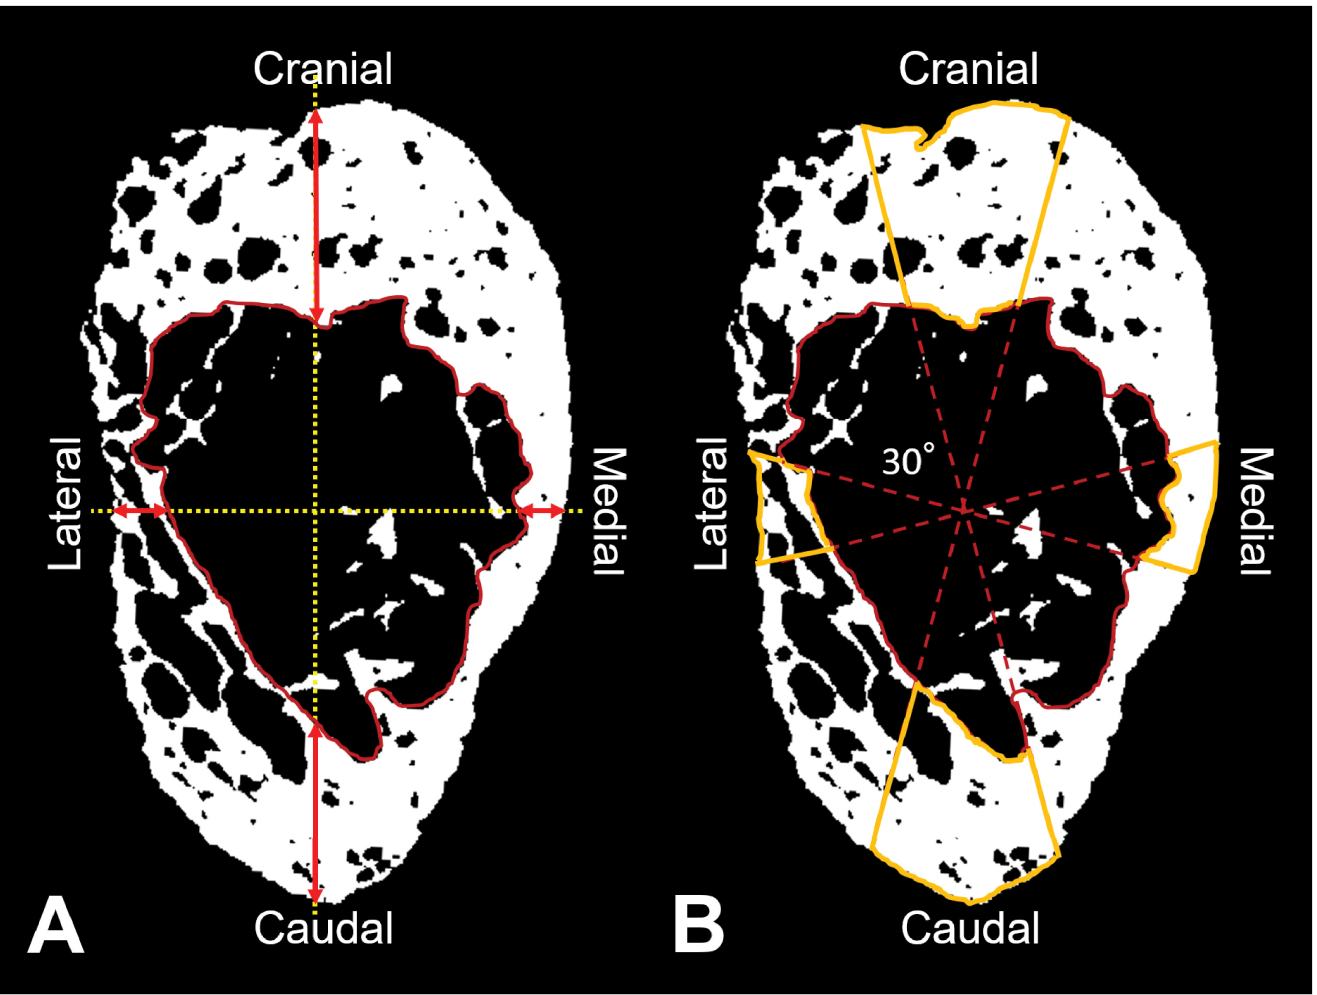
Fig 2. The pedicle dimensions and the four regions (ROIs) for analyses of bone area fraction overlaid on the binarized μ CT image. A: The yellow vertical and horizontal dotted lines depict the major and minor axes, respectively. The red arrows show the thicknesses of the medial, lateral, cranial and caudal wall. The area surrounded by the red solid line is the medullary cavity area. B: Orange solid line contours outline the ROIs for measurement of bone area fraction at each